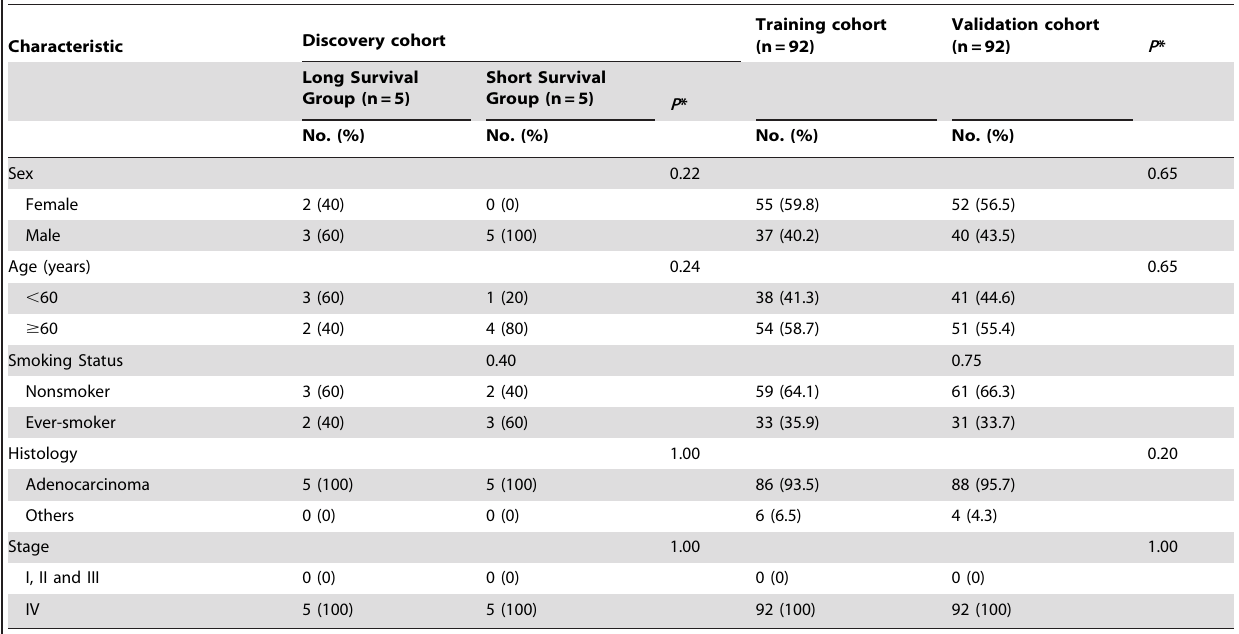
Table 1. Characteristics of study